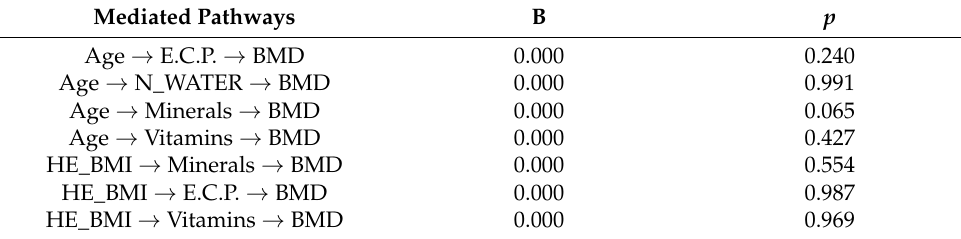
Table 8. Results of mediated pathways in postmenopausal women with bone mineral